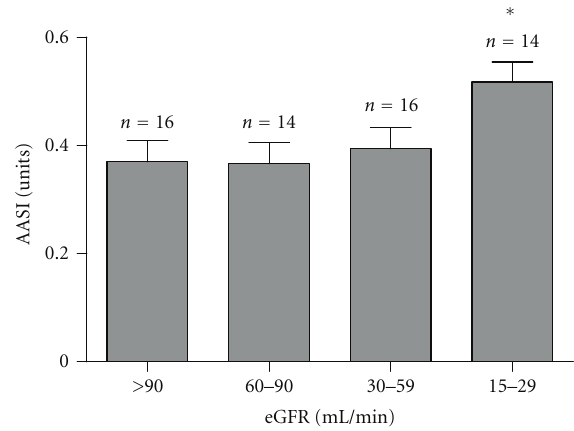
Figure 3: Ambulatory arterial sti ff ness index (AASI) according to estimated glomerular filtration rates (eGFR). Data are presented as mean ± SEM. ∗ P < 0 . 05 versus other